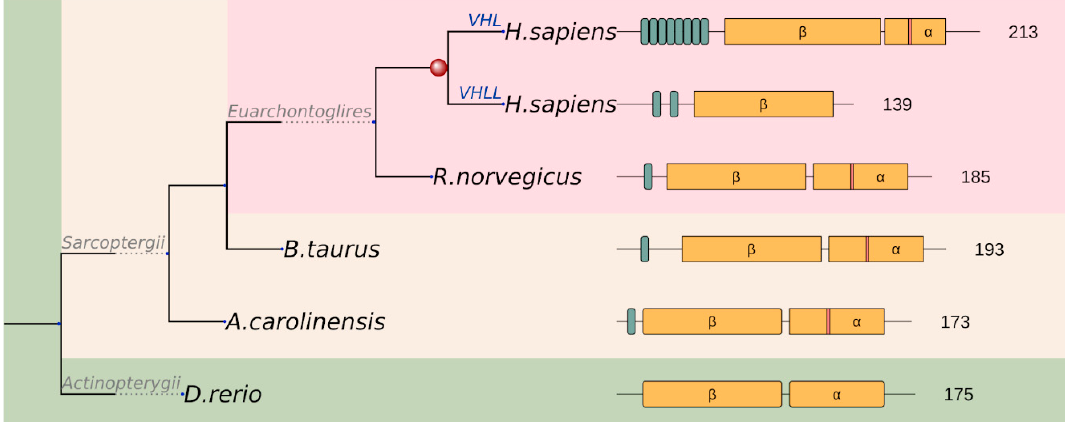
Figure 6. Schematic representation of the evolutionary scenario of the VHL family and the functional units of the members. Repeat units in varying numbers and the α and β core domains are depicted by green and yellow boxes, respectively. Red stripe in the α domain of human VHL indicates K171 identified to emerge by positive selection on the Sarcopterygii branch (mapped K171 to other Sarcopterygii are also indicated by red stripes).